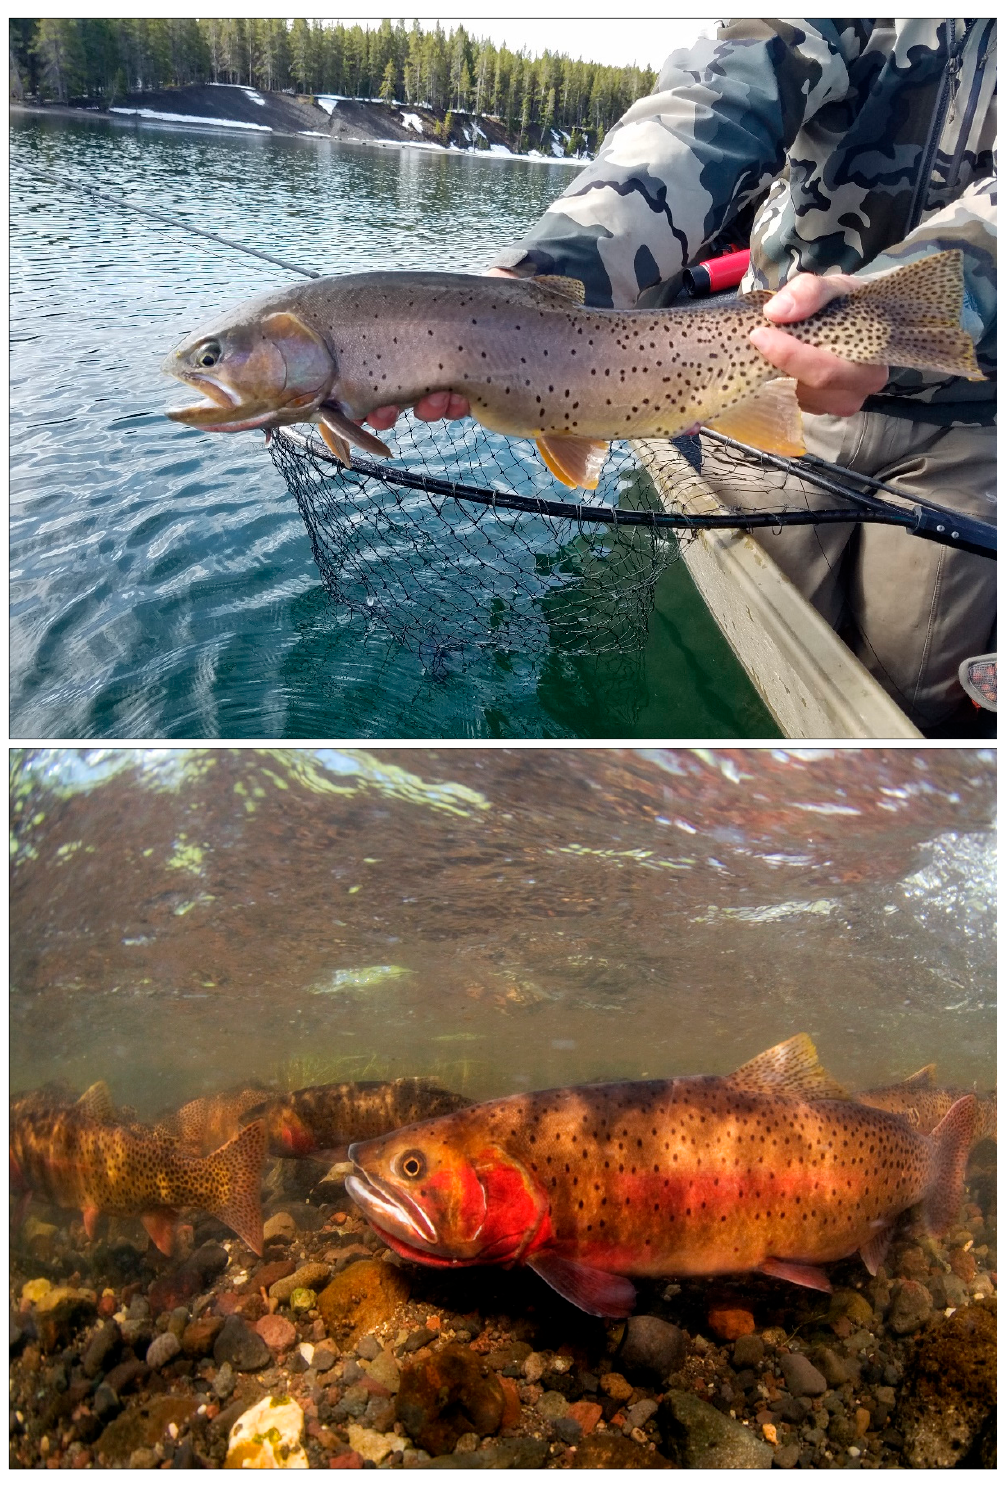
Figure A2. Native cutthroat trout accessed the upper Yellowstone River and Yellowstone Lake from the upper Snake River via natural connections across the Continental Divide following glacial recession about 14,000 years ago. Cutthroat trout then evolved as the sole salmonid and dominant fish within the lake and its connected river network.